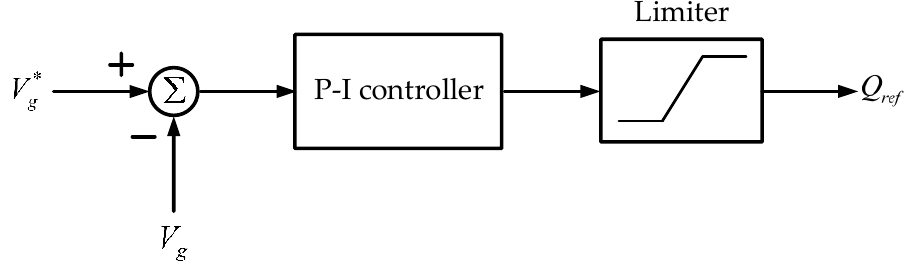
Figure 9. The reactive power control architecture for the smart inverter.